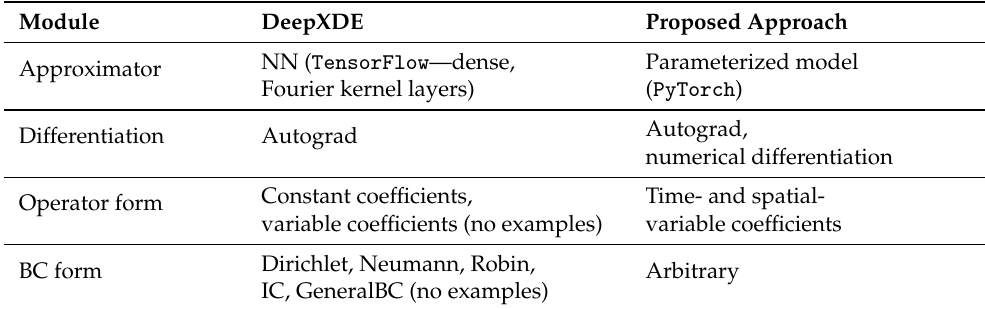
Table 1. Comparison of the proposed approach with DeepXDE for some parameters.